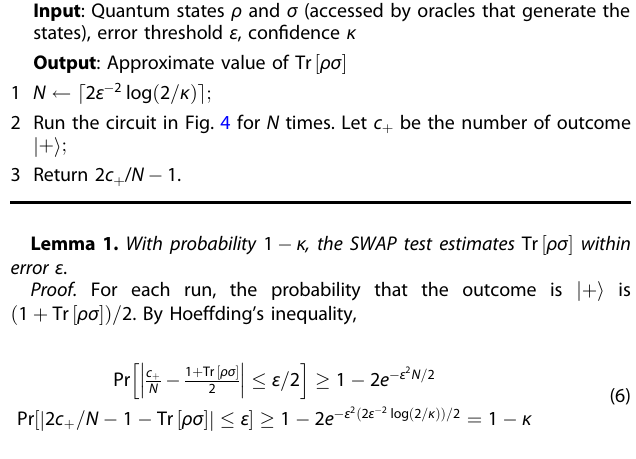
Fig. 4 to estimate Tr ½ ρσ (cid:4) for two given quantum states ρ and σ . If we run the circuit in Fig. 4 for N times and let c + be the number of times observing outcome þj i , then 2 c + / N − 1 is an estimate of Tr ½ ρσ (cid:4) . The algorithm that yields an estimate of Tr ½ ρσ (cid:4) is as follows, which produces an estimate with error no more than ε with probability 1 − κ as shown in Lemma 1.